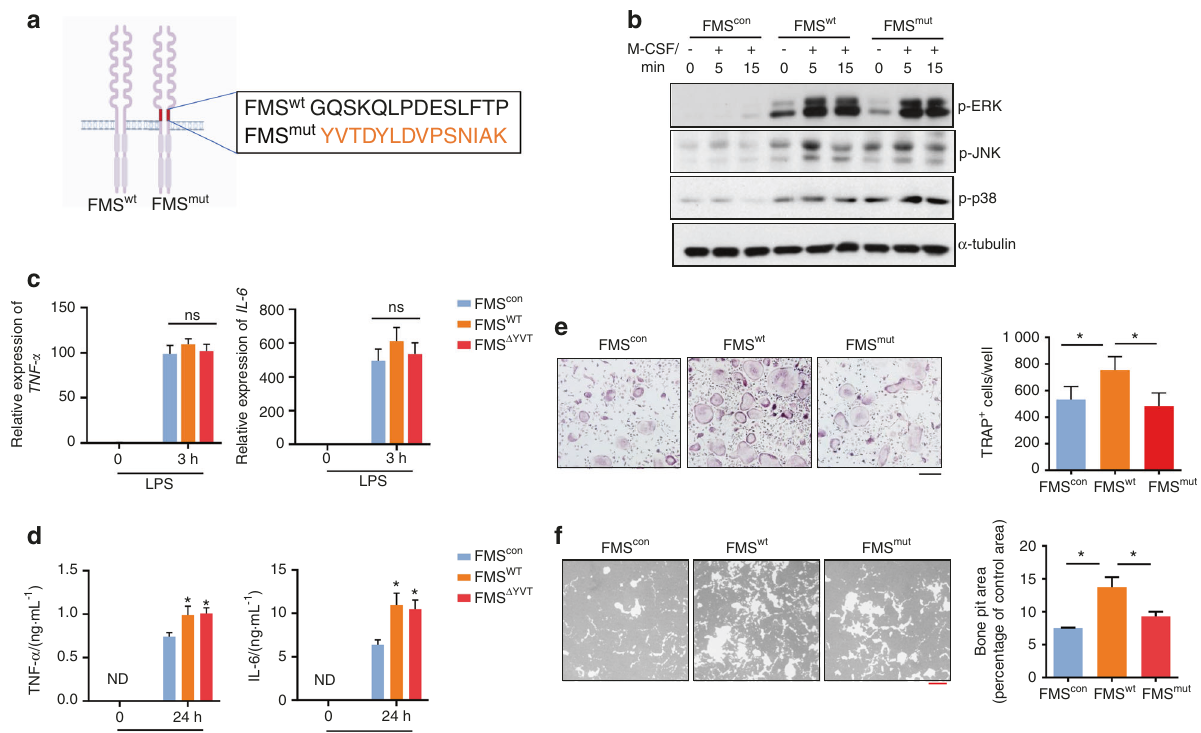
Fig. 3 c-FMS proteolysis positively regulates osteoclastogenesis. a Schematic showing mutations in the TACE cleavage sites of c-FMS. TACE cleavage sites of c-FMS 10 were replaced by the addition of 14 amino acids from insulin receptor sequences (FMS mut ). b 293 T cells did not express c-FMS and were transduced with lentiviral particles encoding control, FMS wt or FMS mut . The cells were then stimulated with M-CSF for the indicated times. Protein expression of phospho-ERK, phospho-JNK, phospho-p38, and α -tubulin was determined by immunoblot analysis. c – f BMDMs from c-FMS f/ + Mx1-Cre mice were transduced with lentivirus encoding control, wild-type FMS (FMS wt ), or the TACE-uncleavable mutant FMS (FMS mut ). The transduced BMDMs were stimulated with LPS (10 ng·mL − 1 ) for 3 h ( c ) and 24 h ( d ). c The mRNA expression of TNF α and IL6 was measured by q-PCR. d TNF α and IL6 protein levels in the culture media were measured by Luminex multiplex cytokine assays. e Osteoclastogenesis assay. The left panel shows representative images of TRAP-stained cells. The right panel shows the percentage of TRAP- positive multinuclear cells (MNCs: more than three nuclei) per control ( n = 6). Black scale bar: 100 μ m. f Resorption pit assay. Bone resorption activity analysis of FMS con , FMS wt , or FMS mut cells. The left panel shows representative images, and the right panel shows the percentage of the resorbed pit area per total area. Red scale bar: 200 μ m. All data are shown as the mean ± SEM. ns not signi fi cant, ND not detected. * P < 0.05 by one-way ANOVA with a post hoc Tukey test ( c – f ). The data represent at least three experiments ( b – d , f